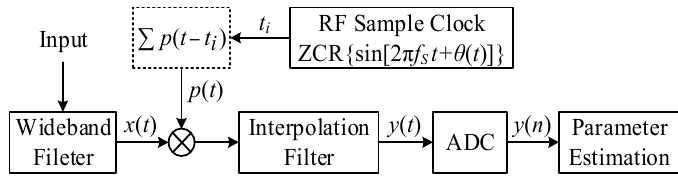
Figure 1. Nyquist Folding Receiver (NYFR) architecture.